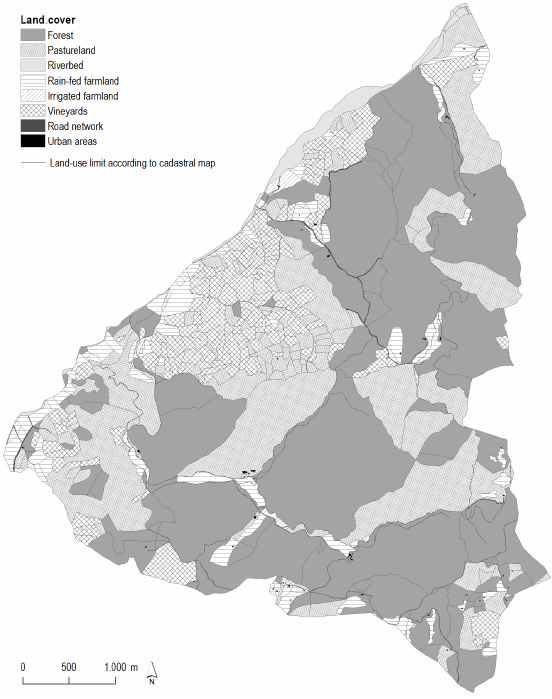
Fig. 3 . Land-cover map of Olzinelles (1850).